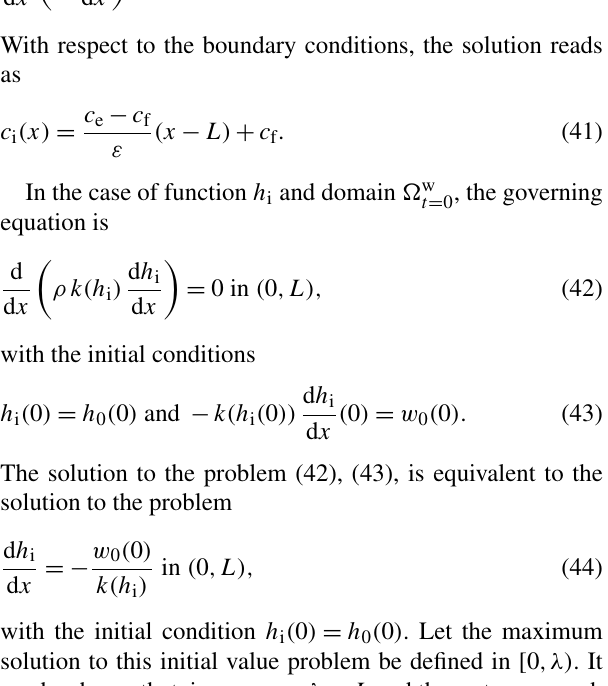
saturated hydraulic conductivity K s = 0 . 0071 cm s − 1 and the diffusion coefficient of water in the gaseous phase within the porous medium D d = 0 . 045 cm 2 s − 1 . Figure 4 shows three